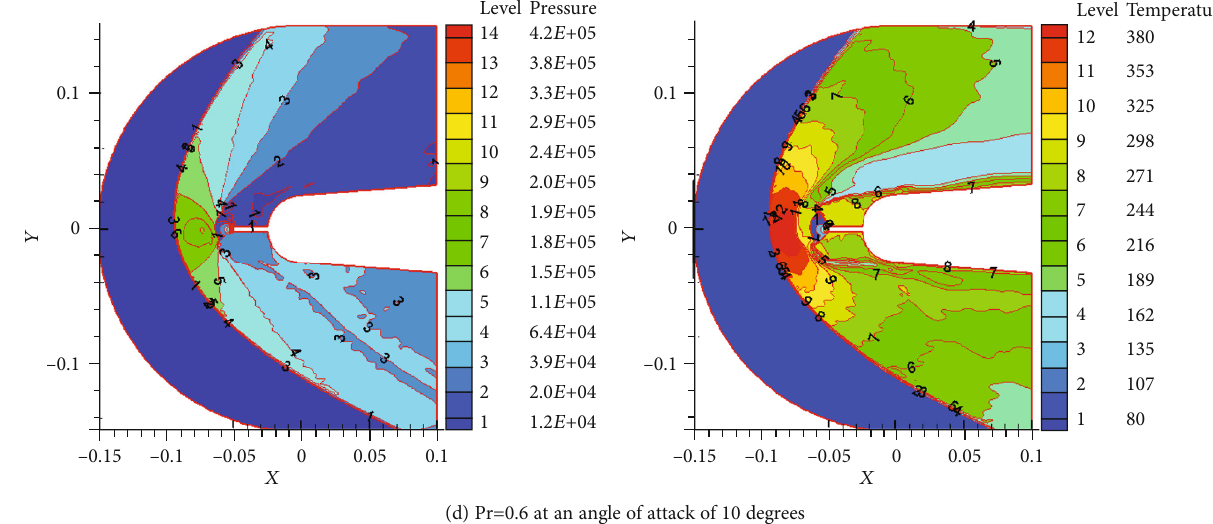
Figure 22: Cloud/contour plots at di ff erent pressure ratios and angles of